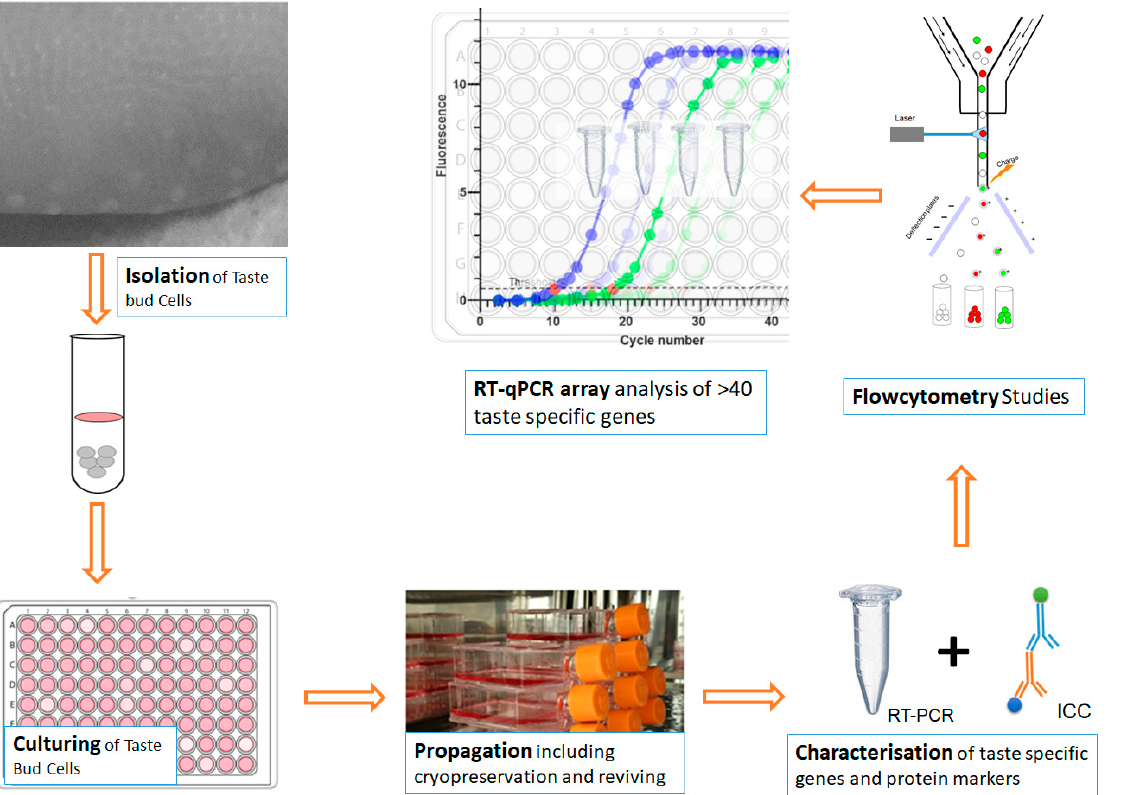
Figure 1. A schematic diagram showing the process of BTBCs isolation, culturing, characterisation using RT-PCR and immunocytochemistry followed by flow cytometry studies and RT-qPCR array analysis of taste specific genes.